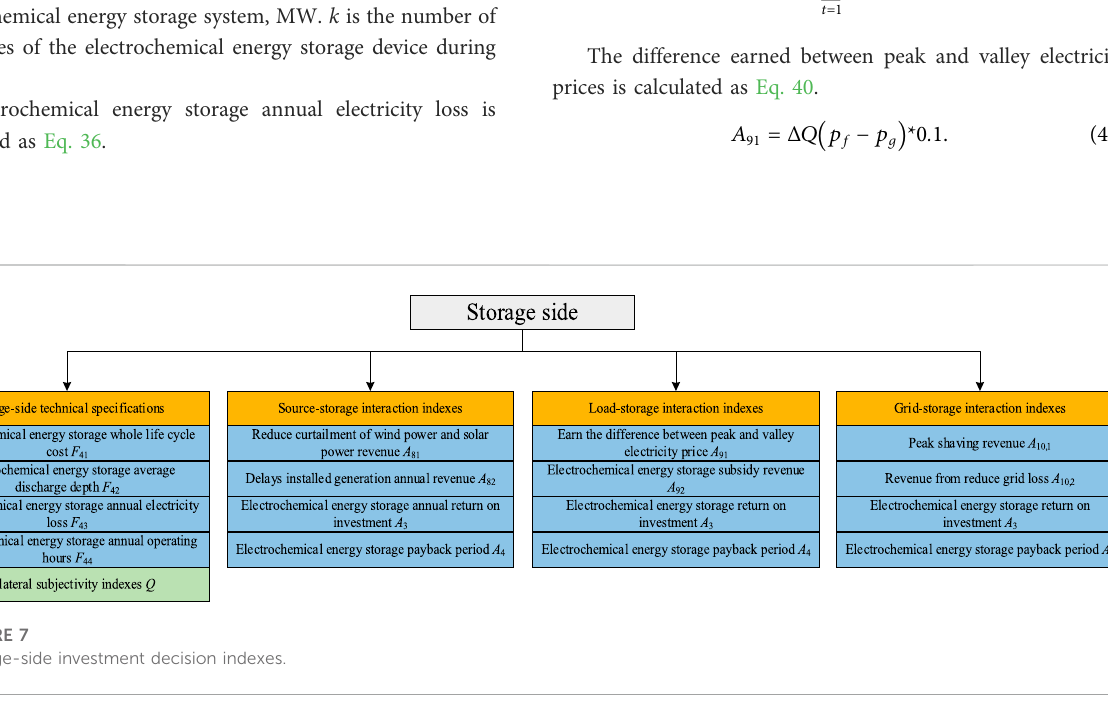
Figure 7. The electrochemical energy storage whole life cycle cost is calculated as Eq. 34.